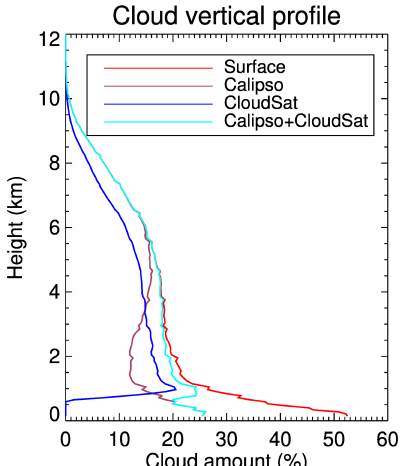
Figure 7. Mean cloud amount vertical distributions from surface observations, simulated CloudSat, CALIPSO, and CC during the SHEBA